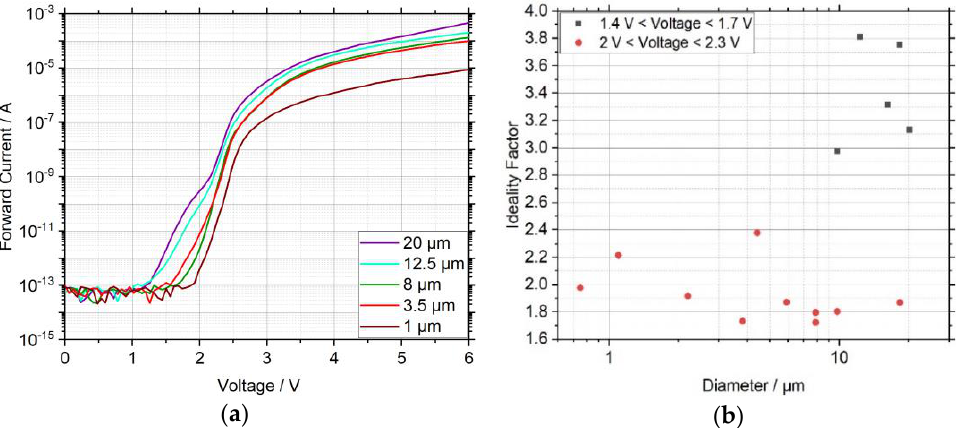
Figure 2. ( a ) Size-dependent IV curves of μLEDs with a diameter between 1 and 20 µm under forward-bias and ( b ) extracted ideality factors for different sizes and voltage ranges. The larger µLEDs show a premature rise of current for low forward voltages, which is accompanied by a